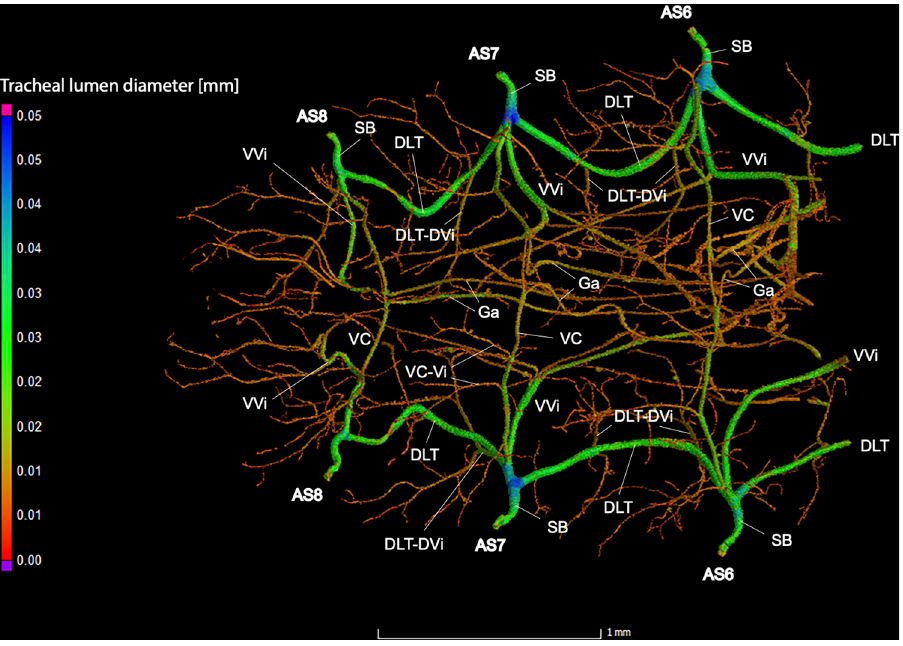
Fig 3. Ventral view of the abdominal tracheal system in Photinus pyralis final instar larva.